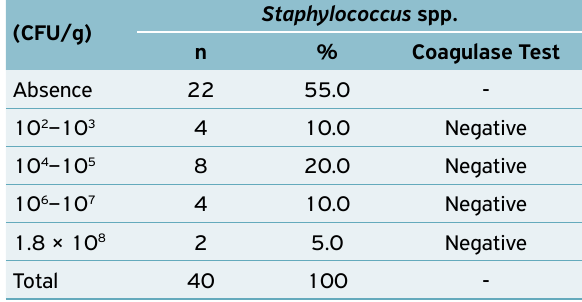
CFU/g: colony-forming units per gram.